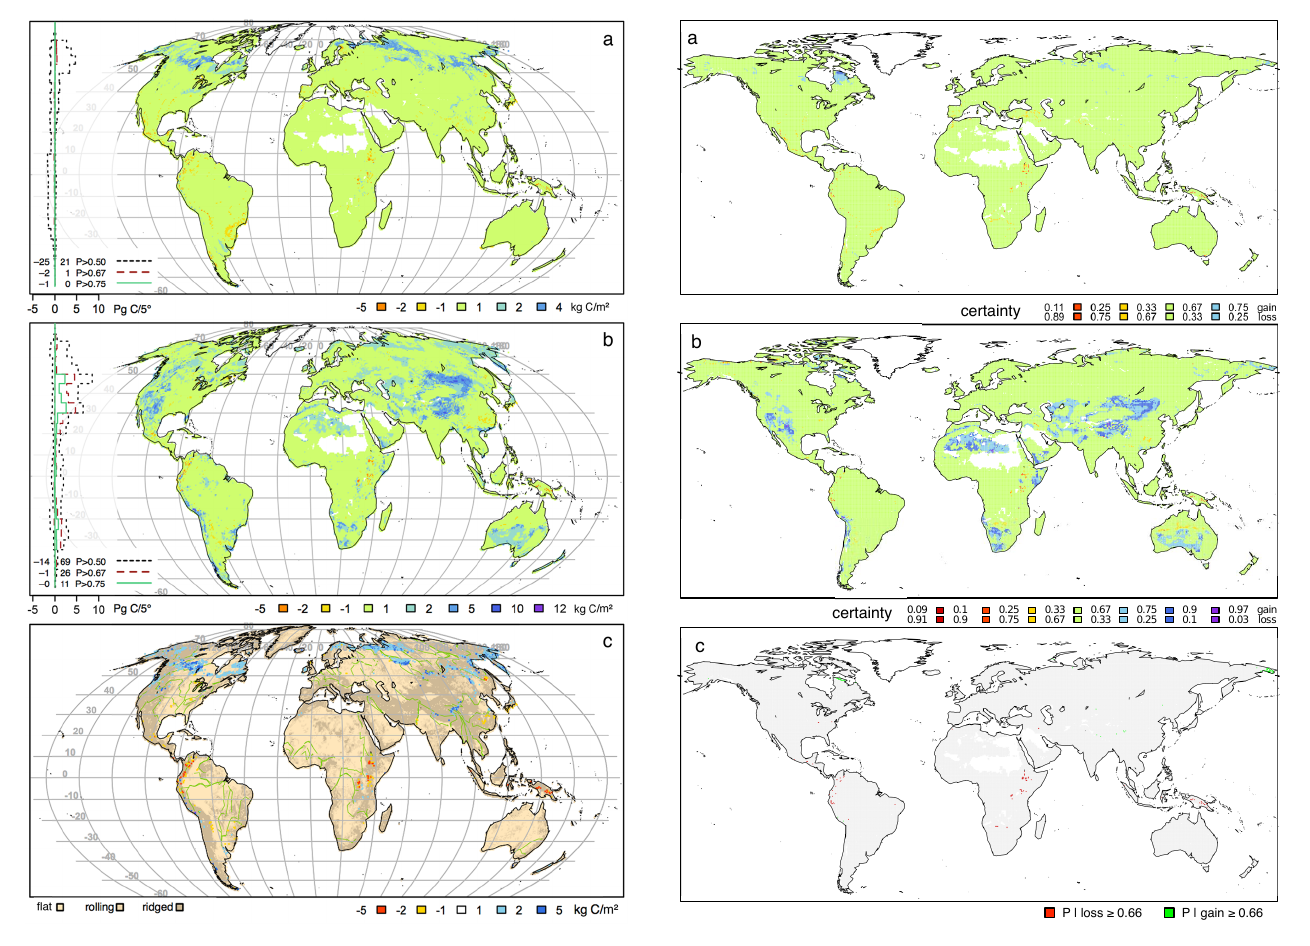
Figure 5. Changes of soil organic carbon stocks and masses using (a) limited NPP and (b) enhanced NPP. (c) Consensus: locations where changes ≥| 1kgm − 2 | in both scenarios, overlaid on topogra- phy.